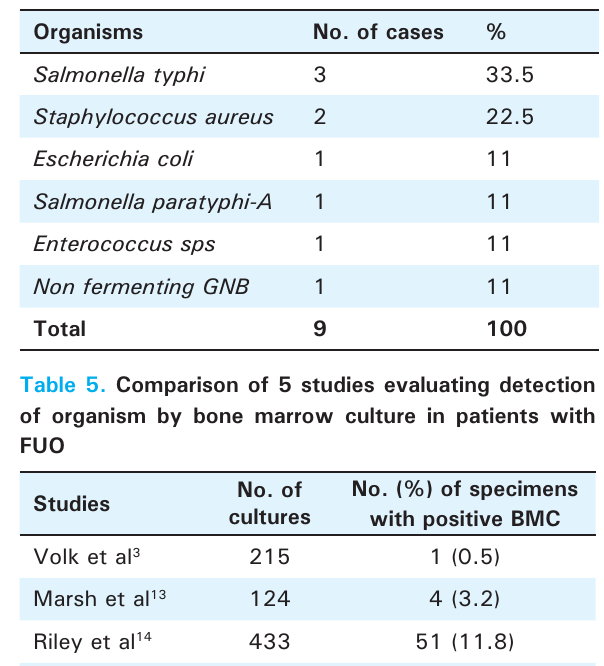
Table 4. Frequency of various organisms isolated in bone marrow culture Organisms